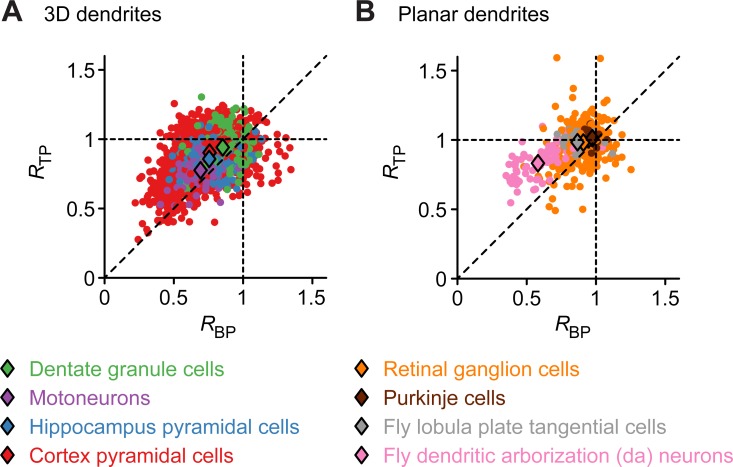
NN distances in 3D and 2D dendrites of real neurons.A.
R values of BPs (x-axis) and TPs (y-axis) for four different mixed populations of 3D dendrites. B. Similar analysis as in A for four mixed populations of planar dendrites. Data were obtained from NeuroMorpho.Org [40]. Colored dots correspond to individual reconstructions and diamonds represent mean values for each cell type.